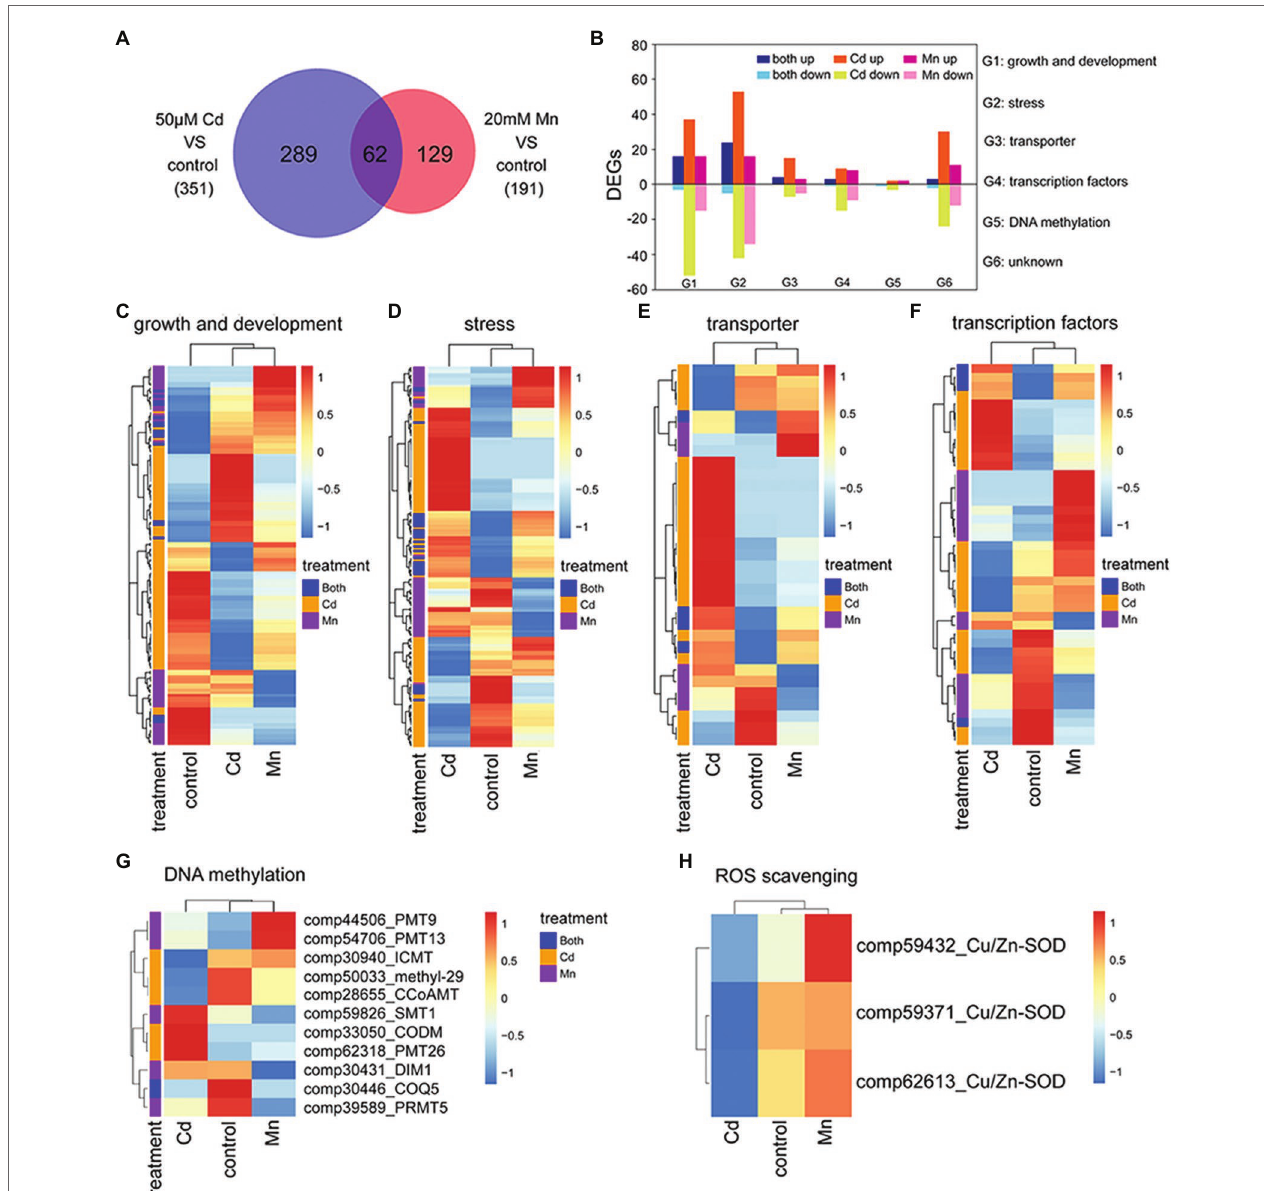
FIGURE 3 | Transcriptomic analysis of seedlings subjected to 20-day Mn, Cd, and control treatments: (A) Venn diagram of DEGs under excess Mn and Cd; (B) number of DEGs assigned to different functions under excess Mn and Cd; (C – G) heatmaps of DEGs included in different functional groups (G1–G5 in panel B ); (H) heatmaps of differential expressions of ROS scavenging-related